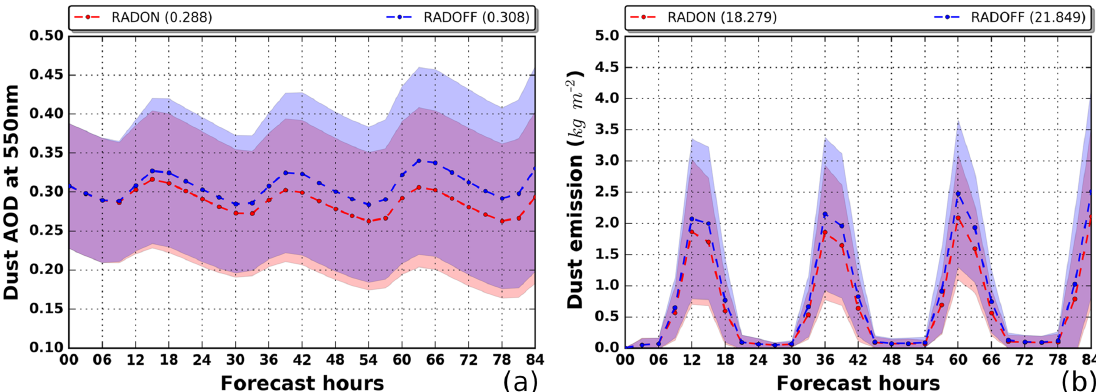
Figure 9. (a) Regional dust AOD at 550nm averaged over the simulation domain (NSD) and (b) regional dust emission (in kgm − 2 ) aggre- gated over the simulation domain (NSD). Blue and red curves correspond to the mean values, calculated from the 20 desert dust outbreaks, for the RADOFF and RADON simulations, respectively, and the shaded areas represent the associated standard